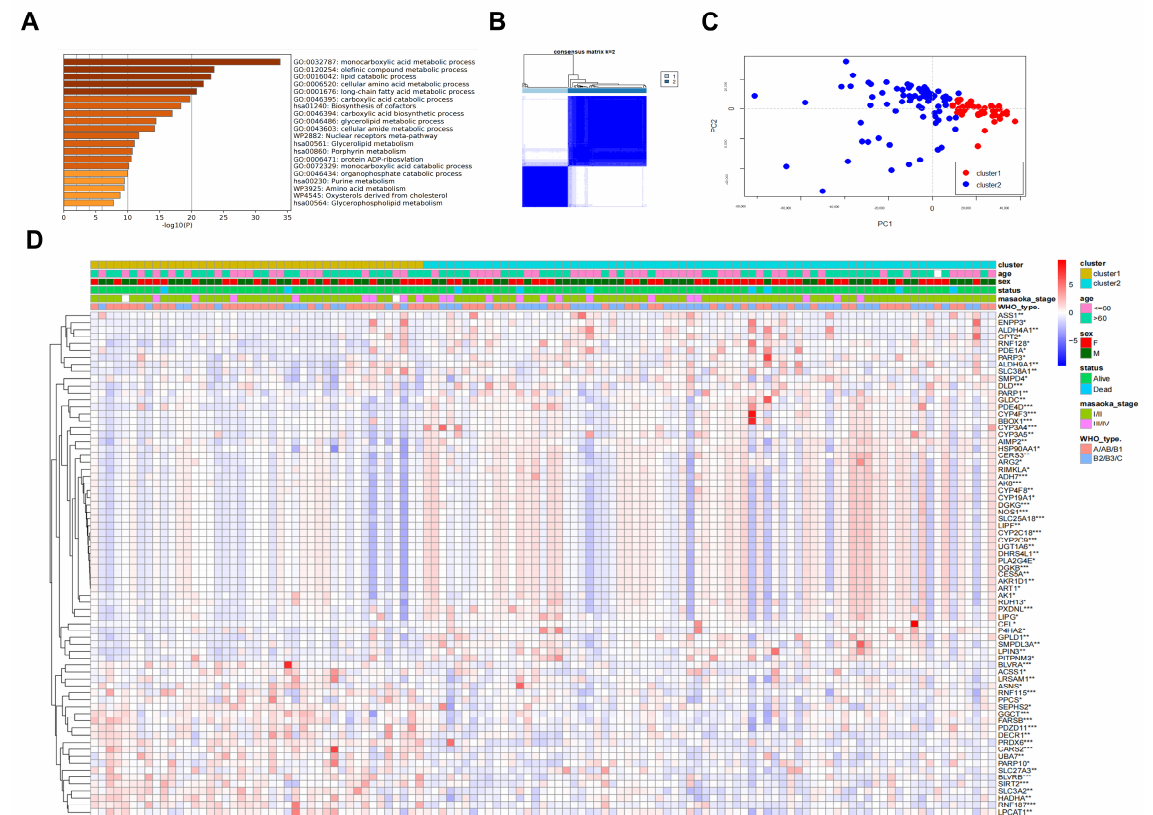
Figure 3. Differential clinicopathological features and enriched pathways of thymic epithelial tumors in the cluster ½ subgroups. ( A ) Gene ontology biological process and pathway enrichment analysis of the TP-MRGs. ( B ) Consensus clustering matrix for k = 2. ( C ) Principal component analy- sis of gene expression patterns between the two subtypes. ( D ) Heatmap and clinicopathologic fea- tures of the two clusters (clusters ½) defined by the MRG consensus expression. * p < 0.05, ** p < 0.01, *** p < 0.001.